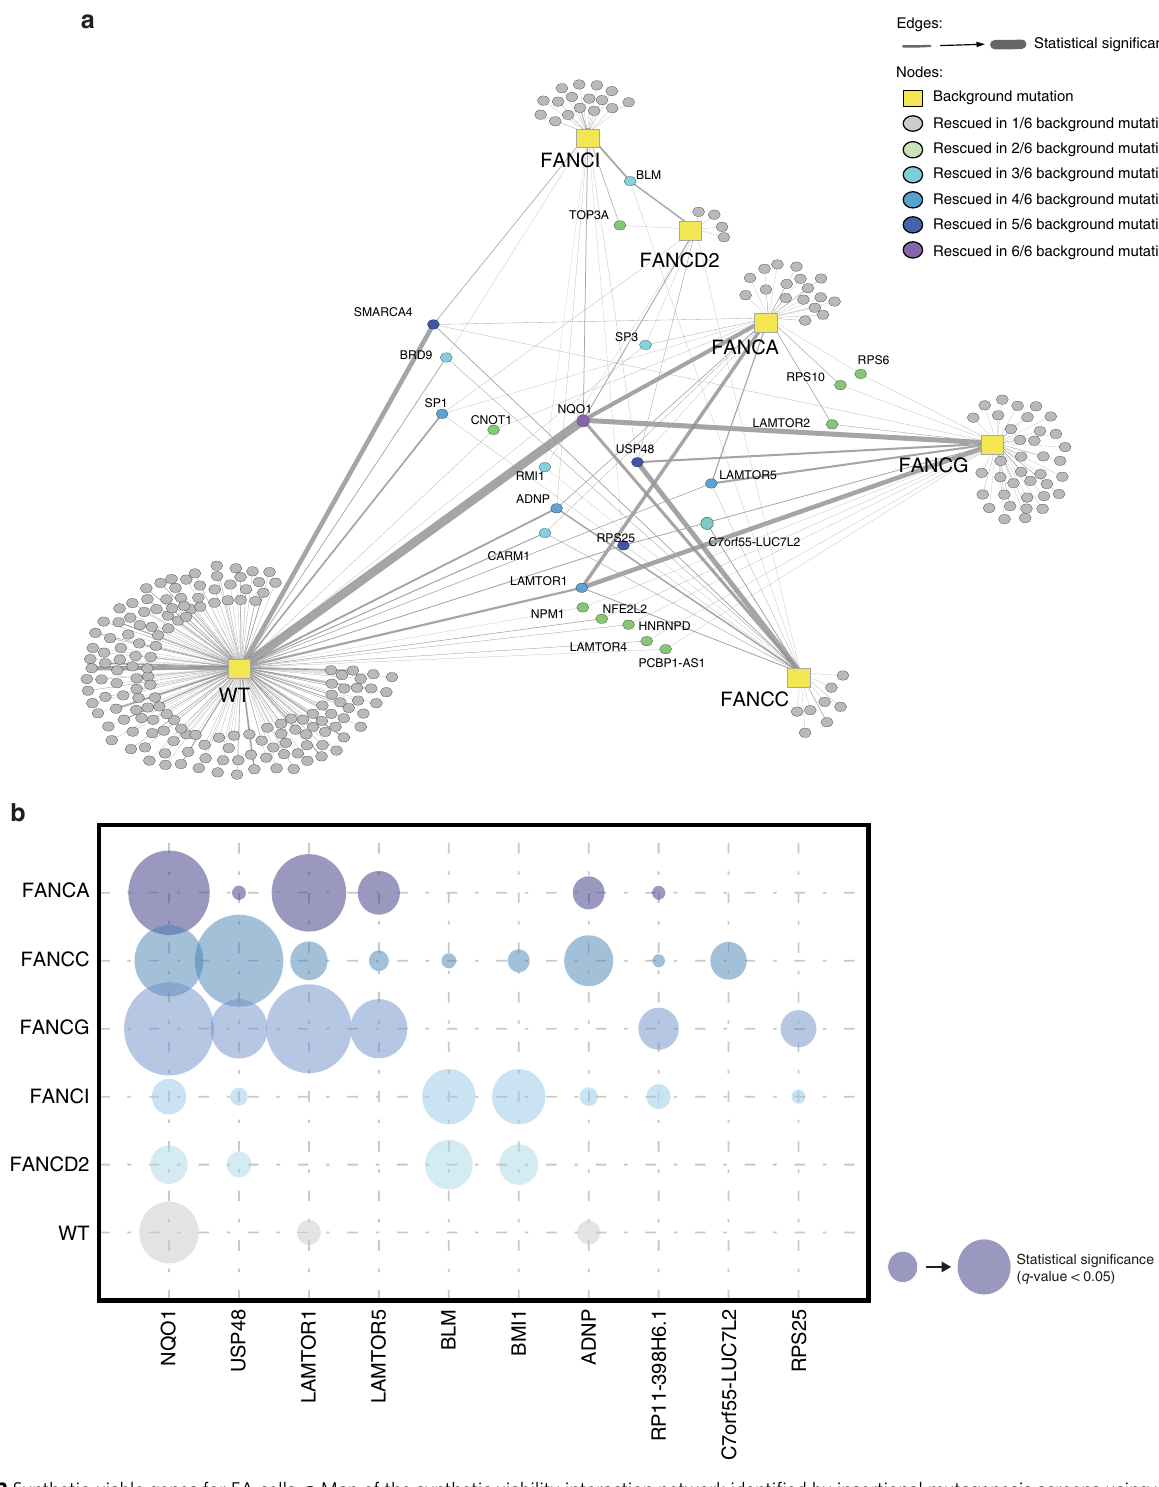
Fig. 2 Synthetic-viable genes for FA cells. a Map of the synthetic viability interaction network identi fi ed by insertional mutagenesis screens using wild-type (WT) and fi ve FA-de fi cient HAP1 cell lines after MMC treatment. Links in this network indicate an increased viability of cell lines with a given mutational background (rectangular nodes) when the respective secondary gene (circles) is also knocked out. A total of 23 genes were found to rescue more than one mutational background (color coded with green to purple), including USP48. b Bubble plot showing the frequency and statistical signi fi cance of the top ten genes identi fi ed in the screens depicted in